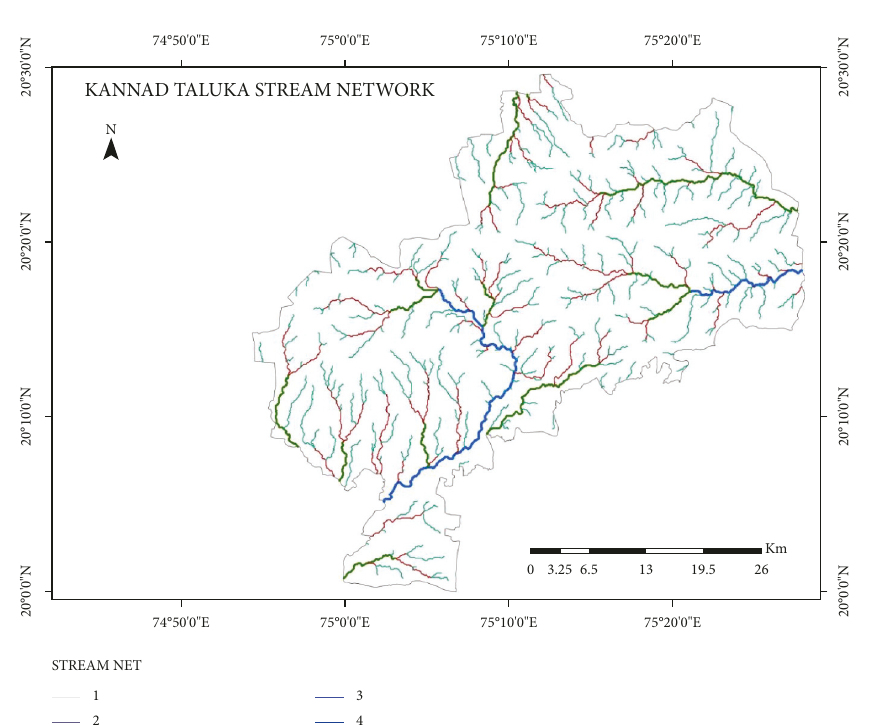
Figure 9: Flow accumulation map of Kannad taluka.